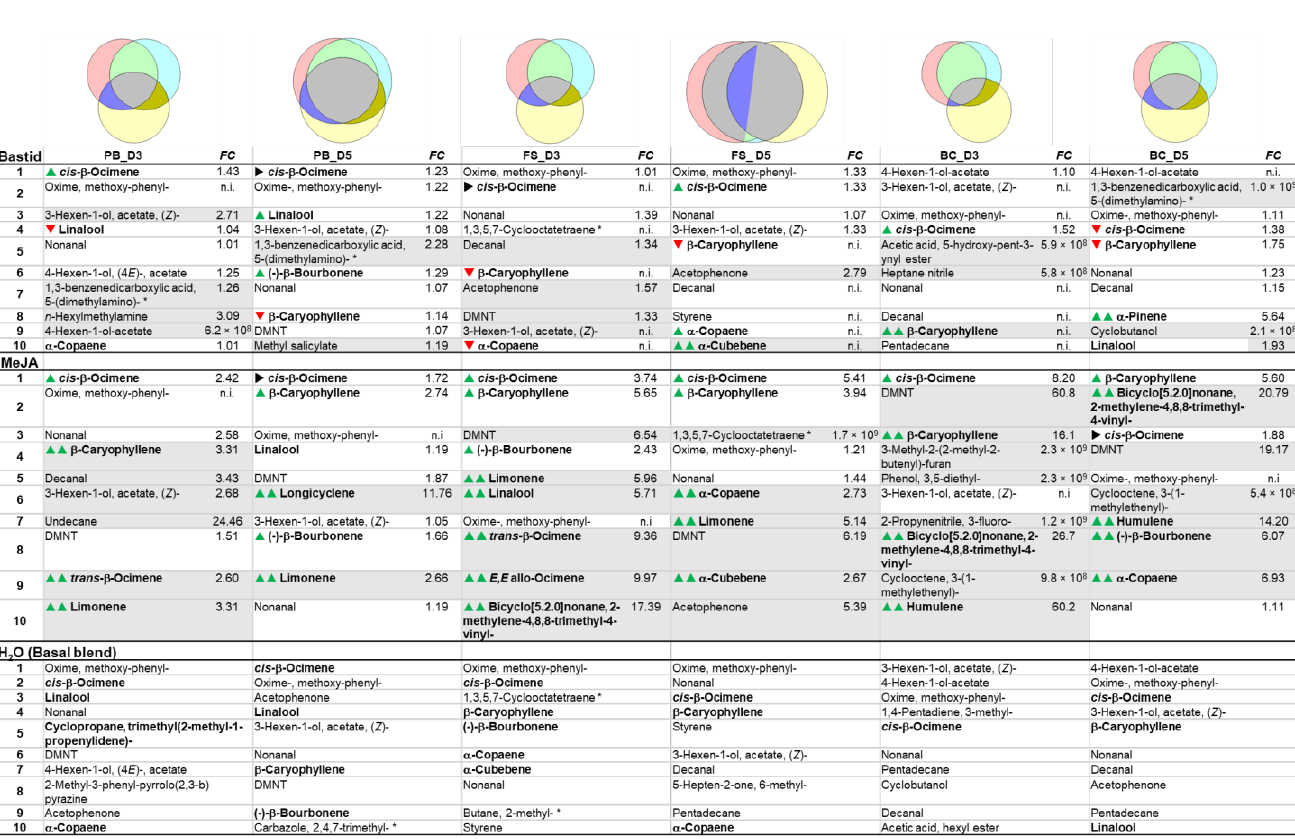
Table 4. TOP10 VOCs detected in the Burgundy vineyard. Venn diagrams of the distribution of the 10 most abundant VOCs detected in Burgundy vineyard (cv. Chardonnay) for each condition and each time point (H 2 O, yellow; Bastid ® , pink; MeJA, light blue). In the tables, compounds are ranked, from 1 to 10, according to their average intensities measured in Bastid ® -(top table), MeJA-(middle table) and H 2 O-(bottom table) treated grapevines. The fold change (FC) relative to the H 2 O control is indicated for each induced VOC. Terpenoids are in bold type. Arrows’ variations of terpenoid ranking relative to H 2 O ( up, stable; down ranking). Grey coloured lines, elicitor-induced VOCs absent in the water control; induced terpenoids. Phenological stages of grapevine: pre- blossom: PB; fruit-set: FS and bunch-closure: BC . Time points: three- and five-days post